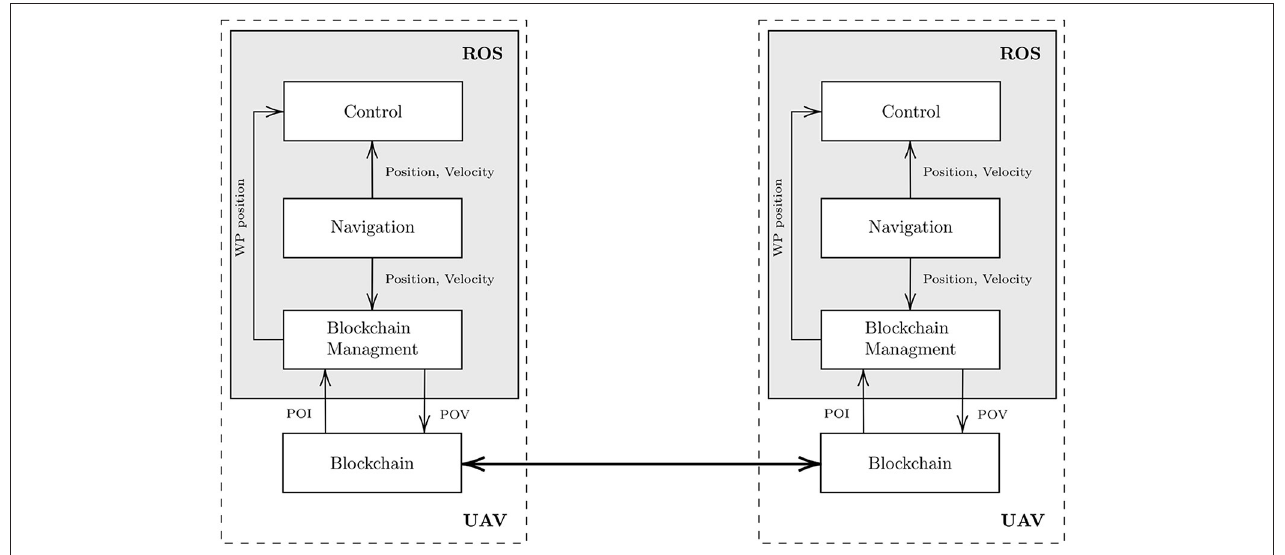
FIGURE 5 | Embedded software architecture proposal. Note that this is a simplified description. For instance, we propose to integrate a Blockchain Management ROS node to ensure the dialogue with the blockchain while controlling the mission execution by sending the WayPoint (WP) position—a POI destination—to the Control